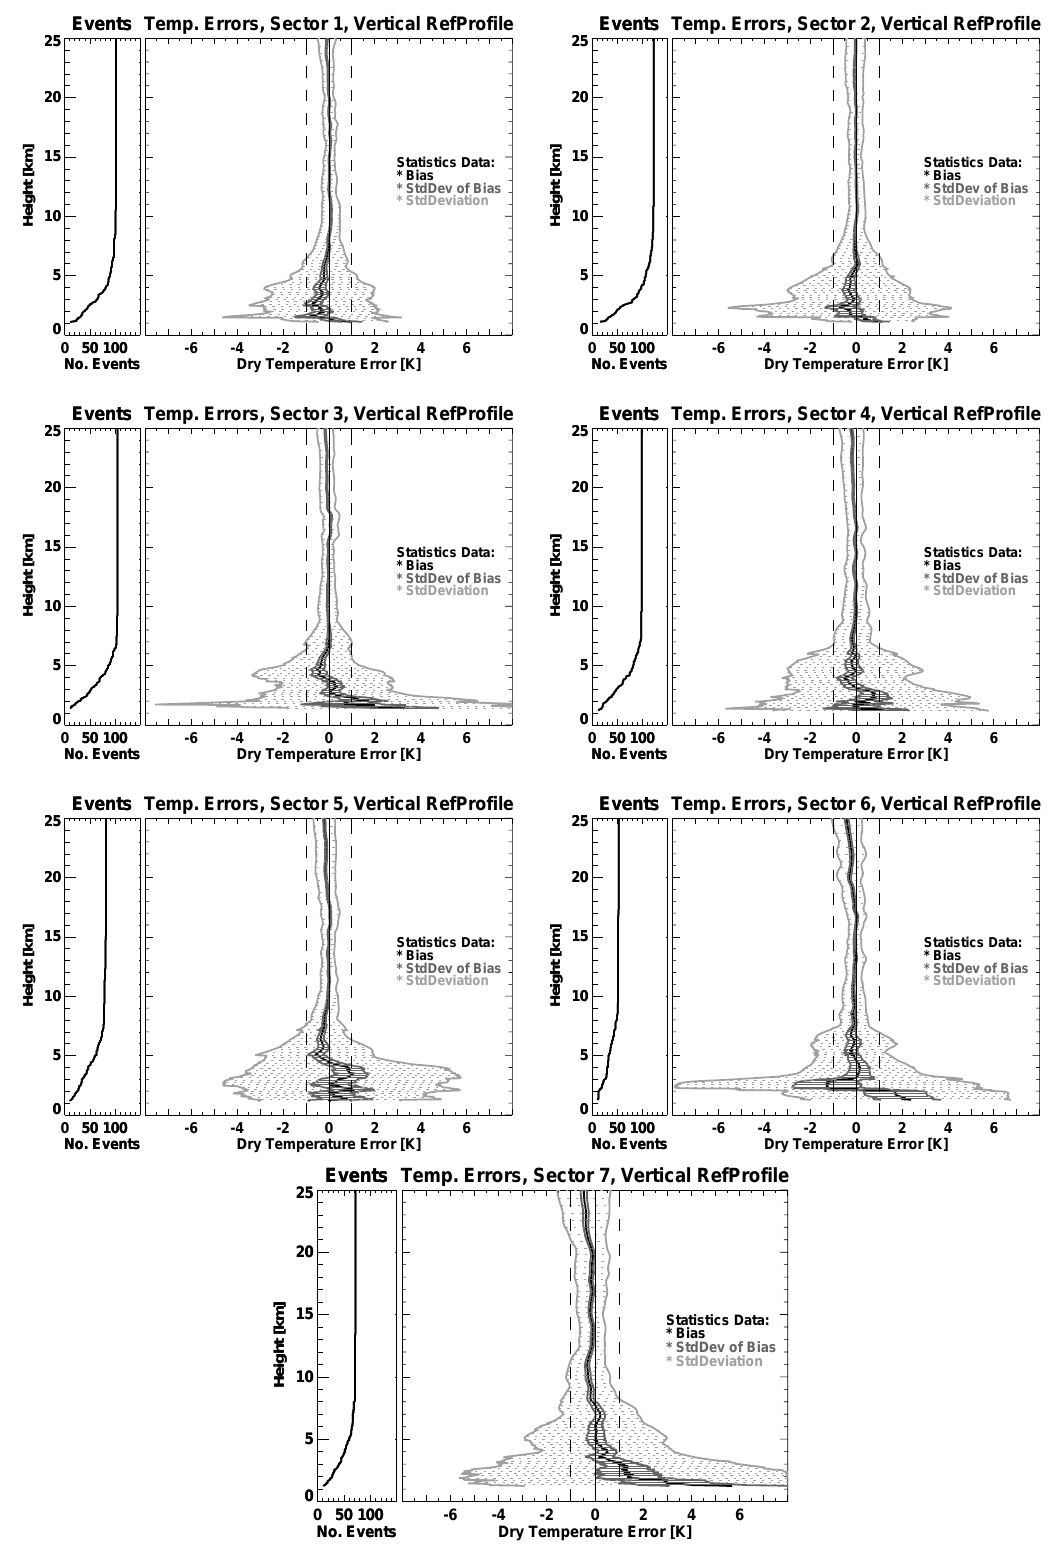
19 Fig. 4. Difference error statistics for dry temperature in sectors 1–7, with the “true” vertical profile at mean tangent point location as